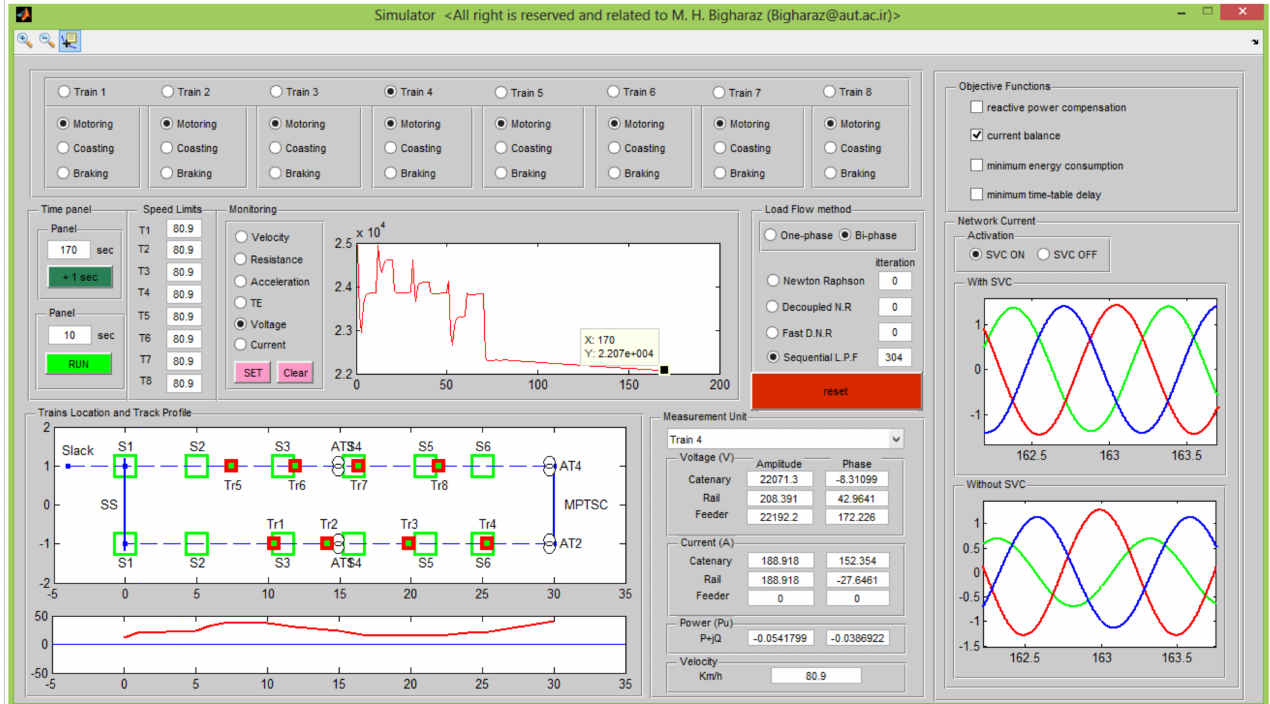
Figure A1. Simulator window specifications developed for electric traction system